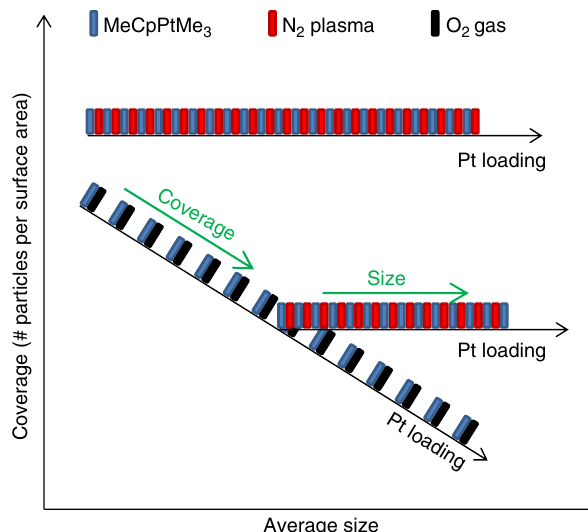
Fig. 4 Morphological tuning of Pt nanoparticles using ALD. ALD recipe scheme showing the evolution of Pt nanoparticle coverage and size during the application of O 2 -based and N 2 * -based Pt ALD cycles. The blue, red, and black rectangles represent exposures to the Pt precursor, N 2 plasma and O 2 gas, respectively. For the O 2 -based Pt ALD process (alternating blue and black rectangles), the coverage decreases and the average size increases with increasing number of ALD cycles. For the N 2 * -based Pt ALD process (alternating blue and red rectangles), the coverage remains constant and the average size increases with increasing number of ALD cycles. By combining both processes, both the particle coverage and particle size can be tuned as indicated by the green